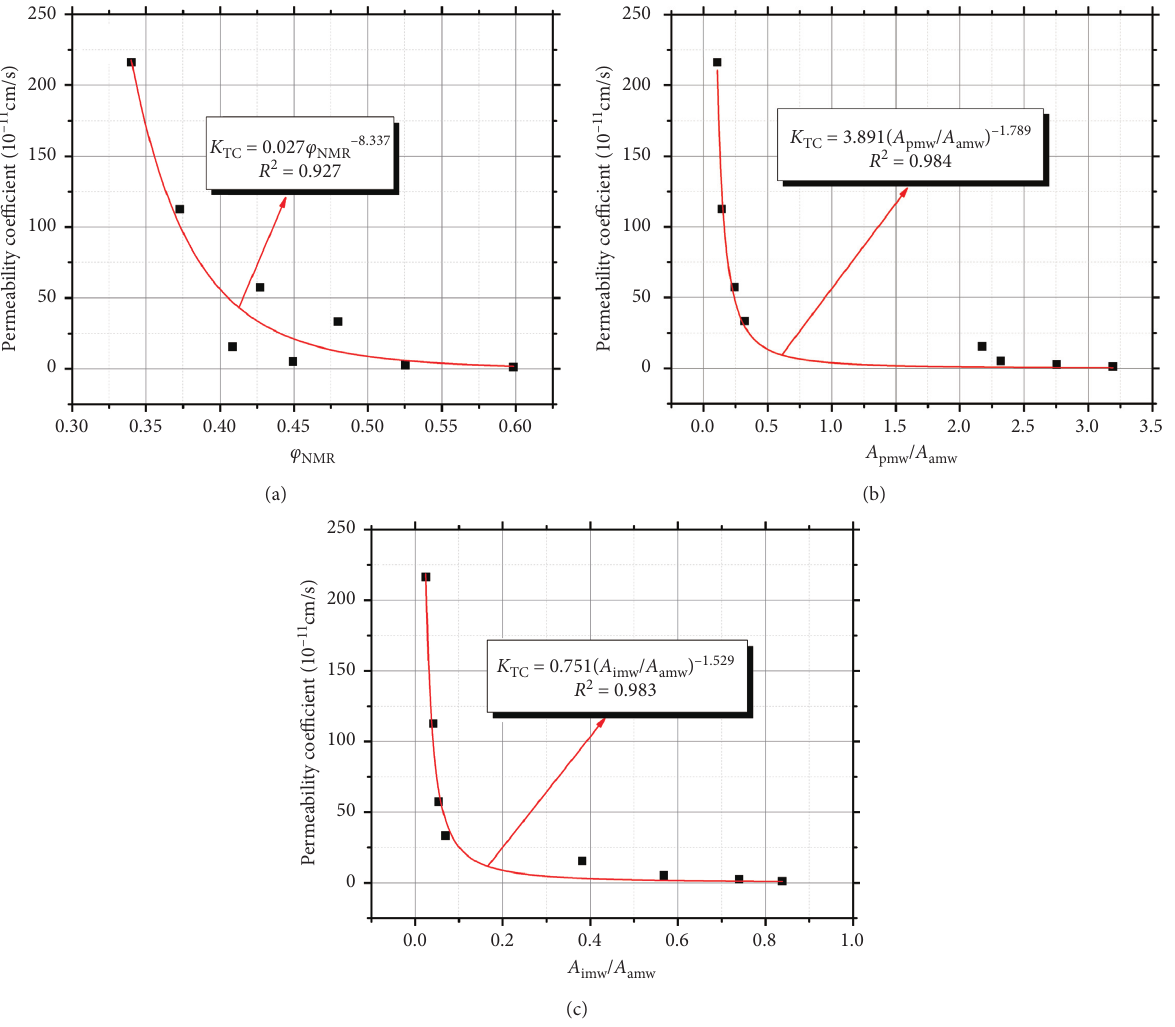
Figure 8: The relationships between K TC and φ NMR , A pmw / A amw , and A imw / A amw : (a) φ NMR , (b) A pmw / A amw , and (c) A imw / A amw .